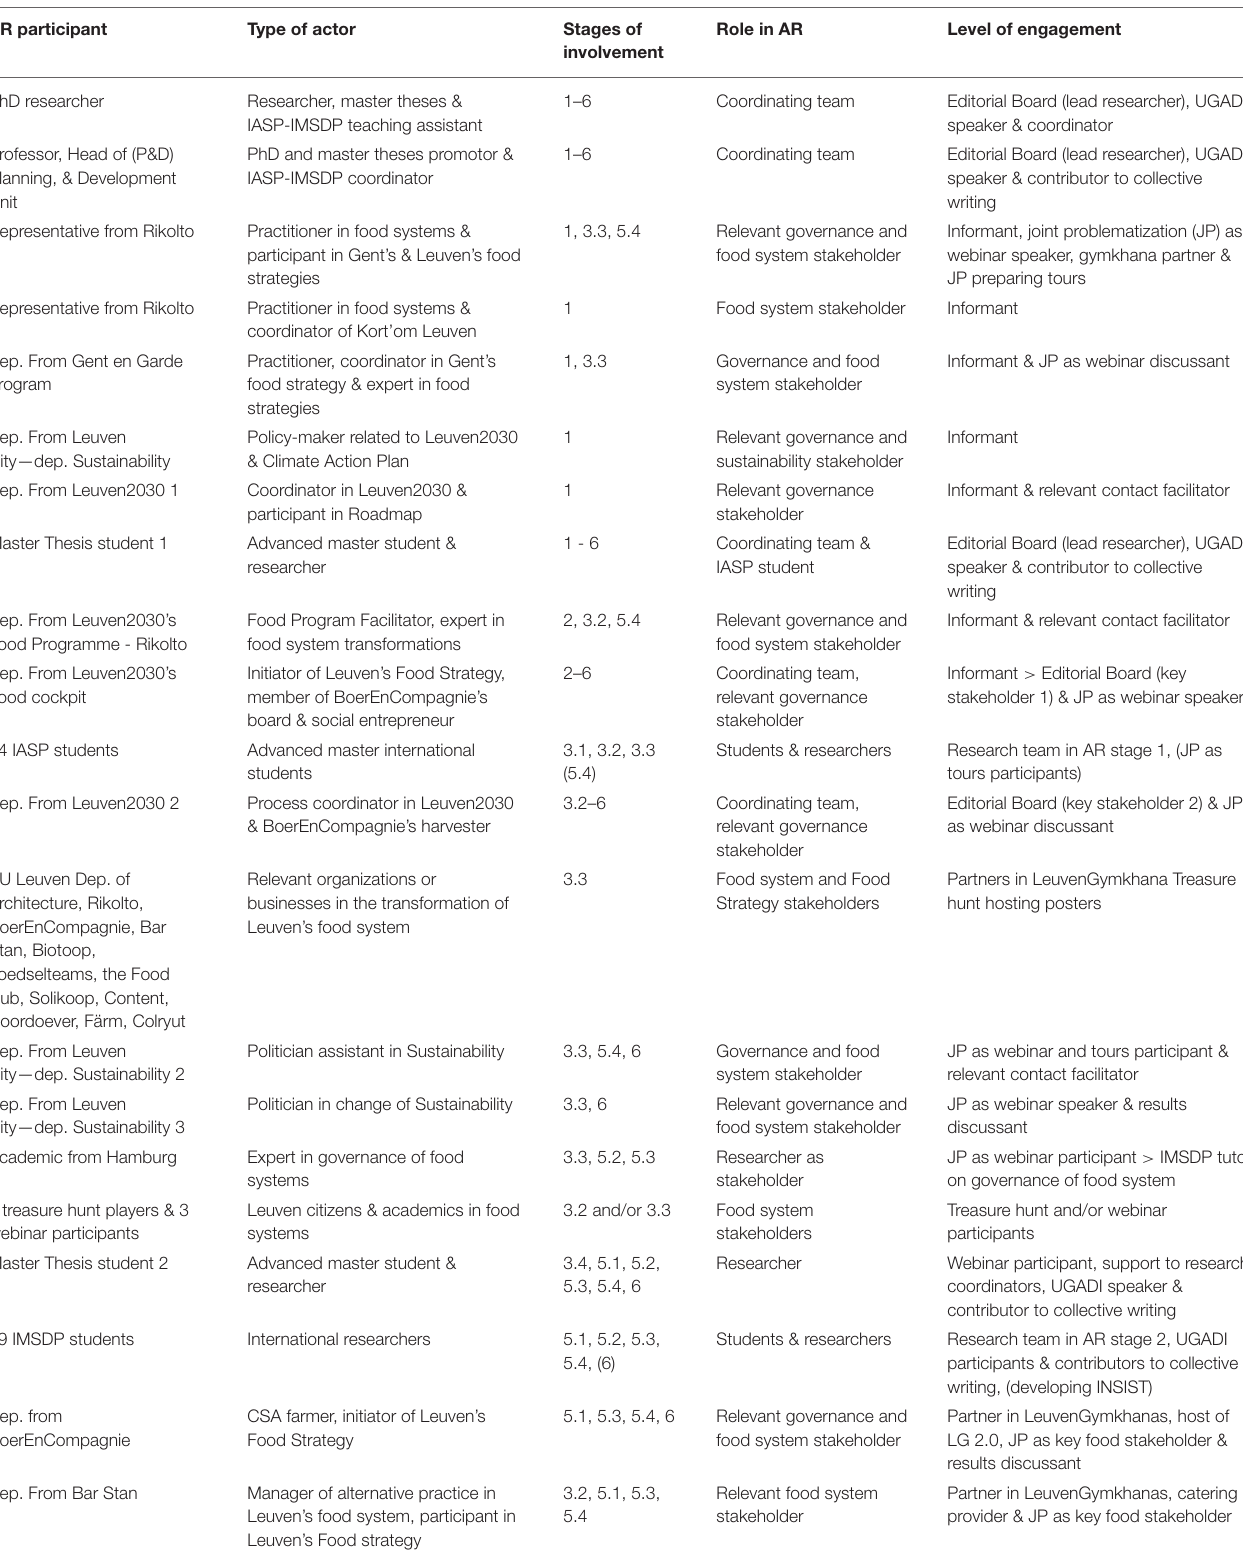
TABLE 1 | List of researchers and stakeholders involved in the AR trajectory in order of